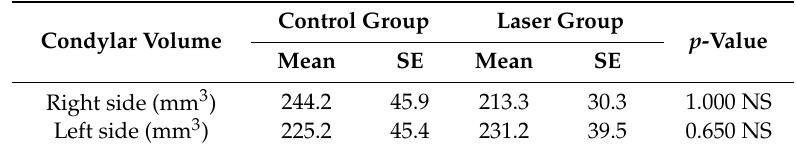
Table 3. Comparison of changes in condylar volume (T1-T2) measurements (mm 3 ) between laser and control groups using independent sample t -test.